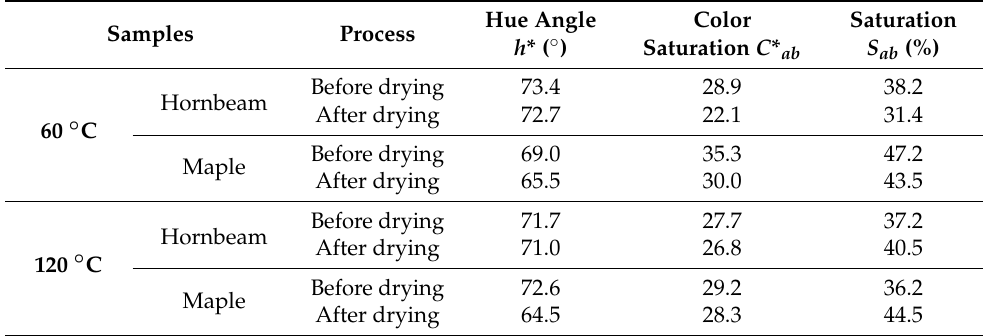
Table 5. Calculated values of hue angle, color saturation and saturation in the hot-air drying (60 ◦ C) and high-temperature drying (120 ◦ C)